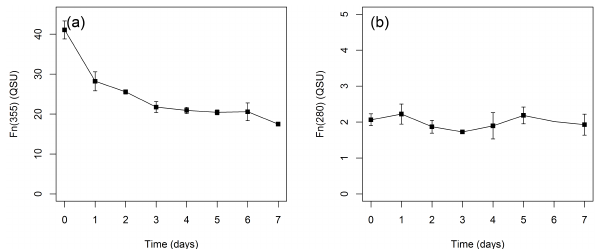
Figure 10. Changes in humic-like fluorescence ( Fn (355)) and protein-like fluorescence ( Fn (280)) for allochthonous CDOM sam- ples with time during photobleaching experiment. Bars show ± standard